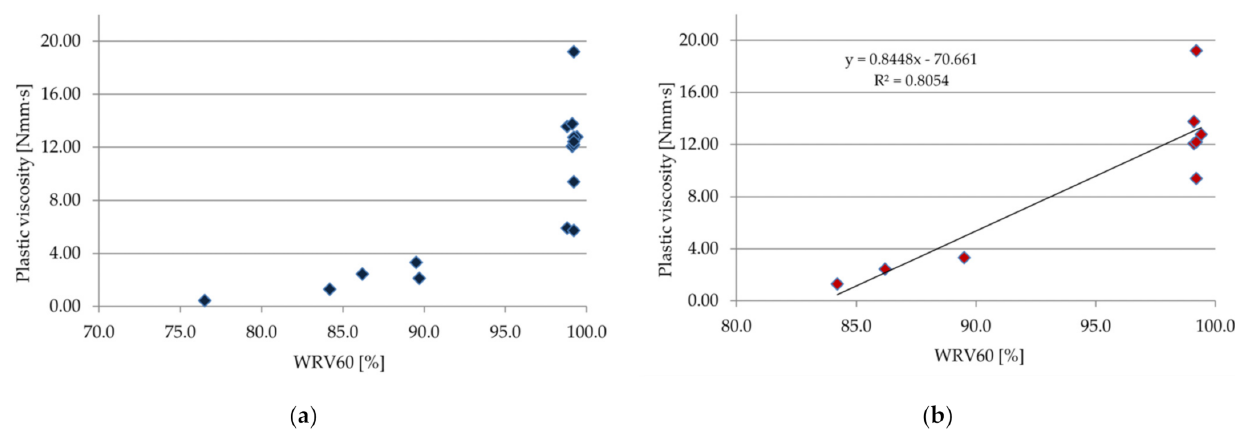
Figure 13. Correlation between plastic viscosity and WRV60 ( a ) for all samples, and ( b ) only for samples with cement– lime